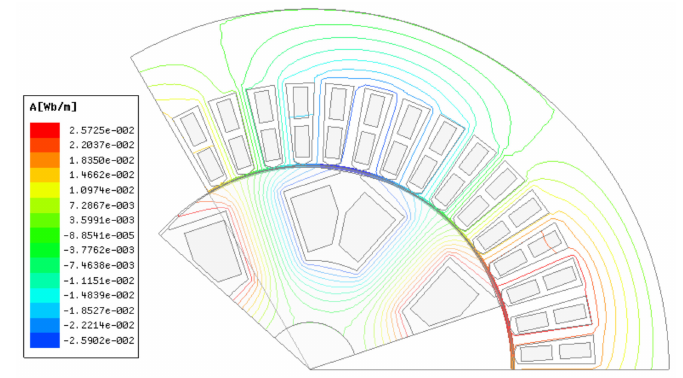
Figure 14. Distribution of magnetic-field lines of the generator.